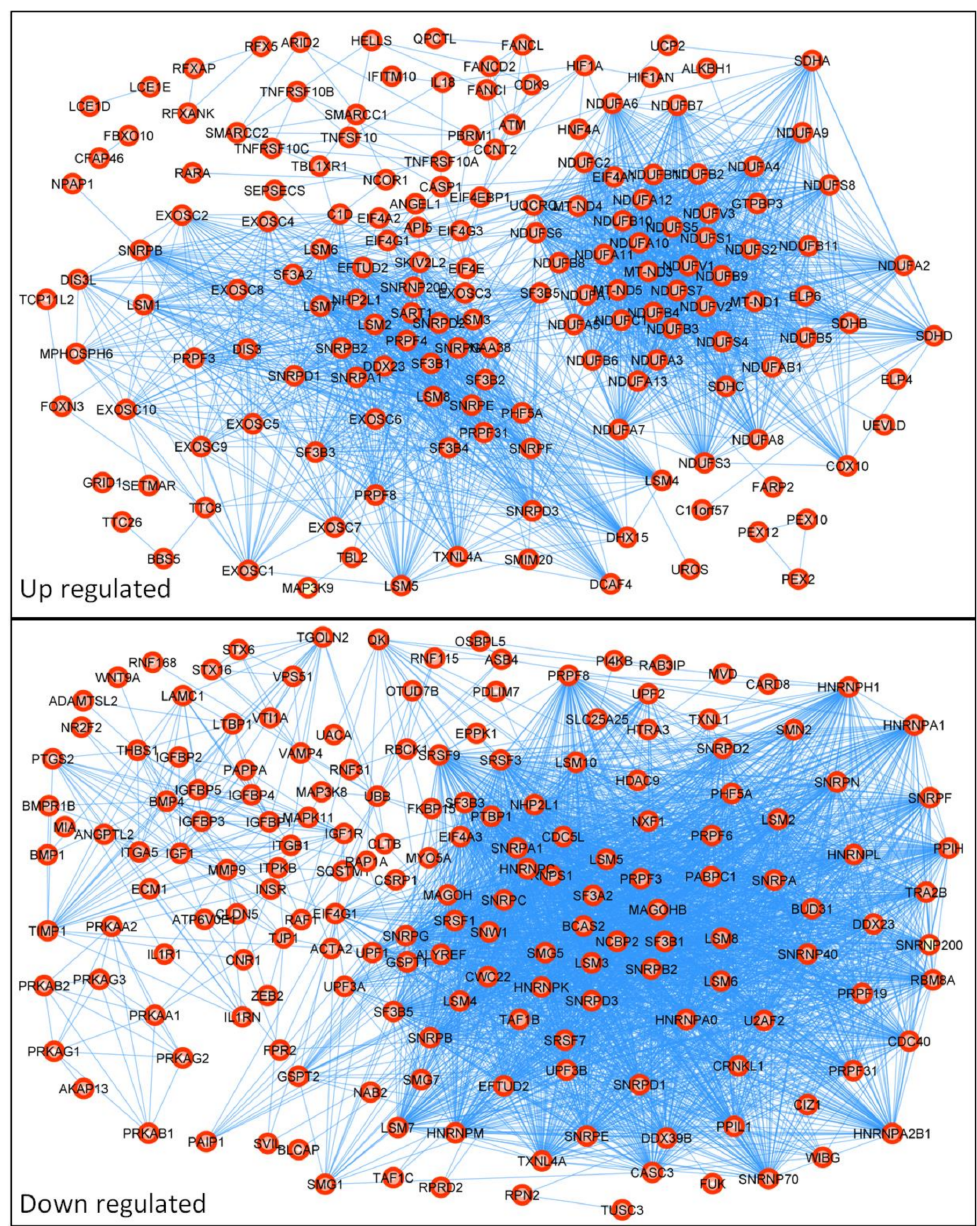
Figure 3. Protein–protein interaction (PPI) network of differentially expressed genes (DEGs). The PPI network was created from 250 differently expressed genes obtained from the GSE62080 database using STRING version 11.0 online software. The PPI pairs were imported into Cytoscape software described in the Materials and Methods section. The lines represent the interaction relationships between